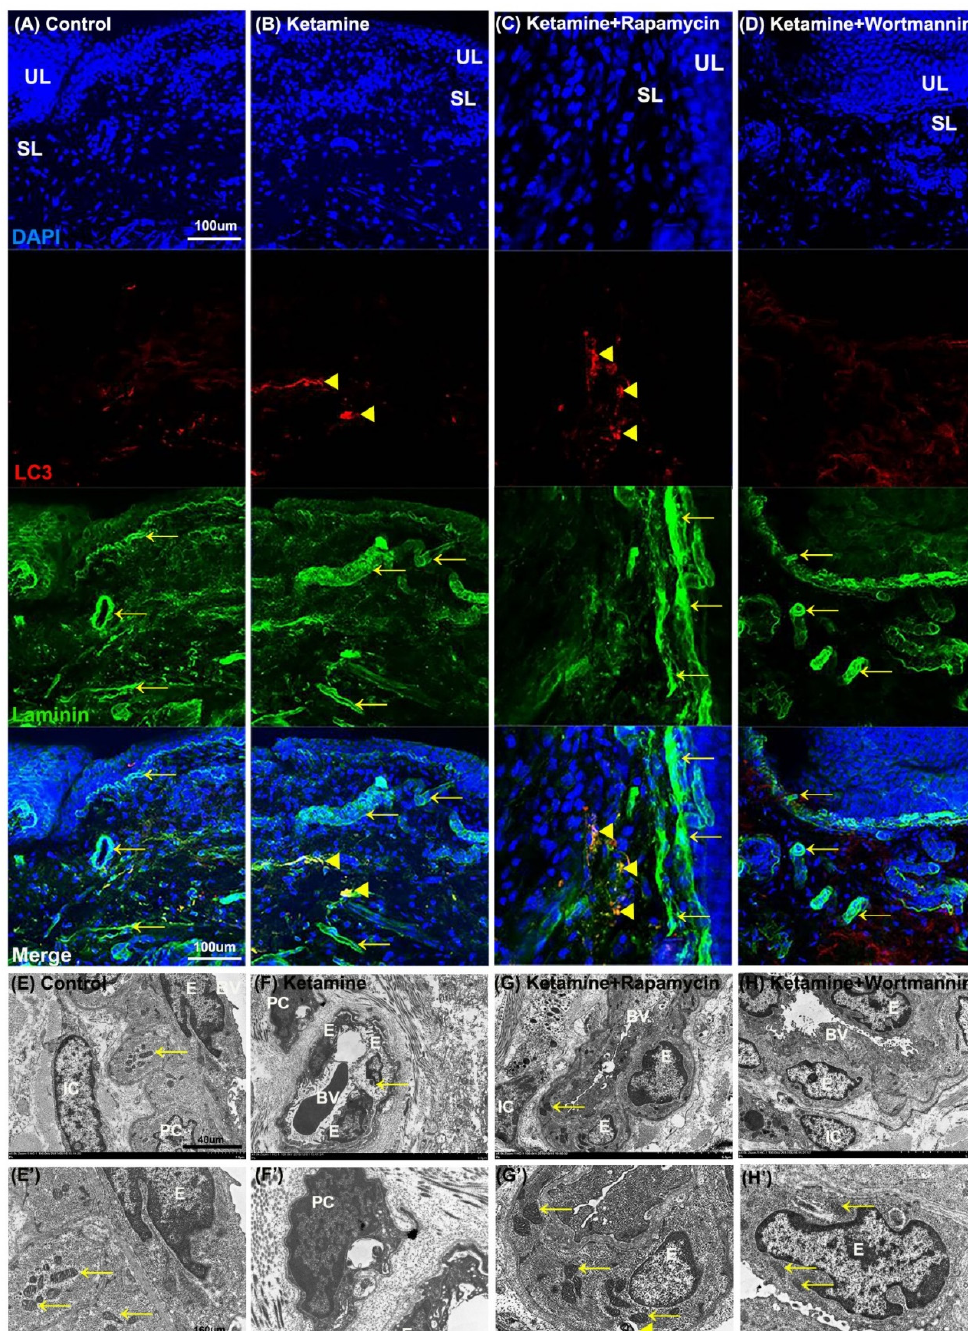
Figure 7. The relationship between autophagy and angiogenesis in the pathogenesis of KIC was evaluated. ( A – D ) Immunofluorescence analysis of Laminin (green) and LC3 (red) expression after treatment with saline ( A ), ketamine ( B ), ketamine+rapamycin ( C ), or ketamine+wortmannin ( D ) in urothelial layer (UL), and suburothelial layer (SL) of bladder tissue. Double immunostaining of laminin (green, yellow arrows, upper right panels) and LC3 (red, yellow arrowheads, bottom left panels) was shown in UL and SL. Nuclear DNA was labeled with DAPI (blue). The merged image from the bottom right panels (yellow) was shown. The LC3 (arrowheads) expression in the SL was identified in the ketamine+rapamycin group. Scale bar = 100 µ m. ( E – H and E’ – H’ ) The ultrastructure of the bladder blood vessel was examined under TEM. Enlarged images ( E’ – H’ ) for prominent ultrastructure of blood vessel from images ( E’ – H’ ) were shown. There was autolysosome in the endothelium of the ketamine+rapamycin group. Scale bar = 40 µ m (Magnification × 4000) and 160 µ m (Magnification × 100,000). Yellow arrows indicated the mitochondria. Yellow arrowheads denoted autolysosome. E, endothelium; IC, interstitial cell; BV, blood vessel; PC, pericyte; LC3, microtubule-associated protein 1 light chain